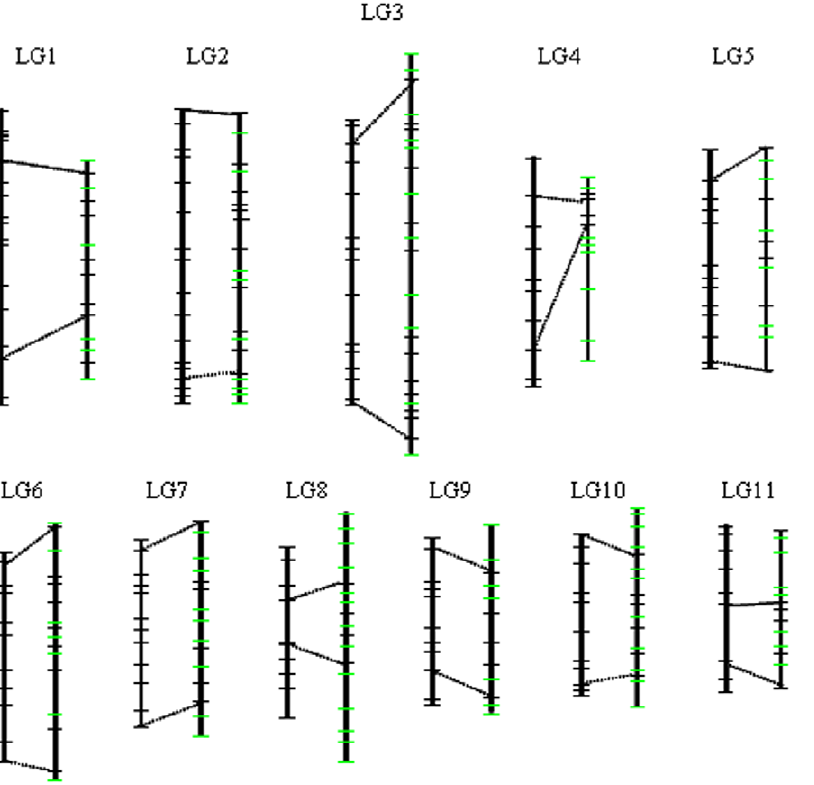
Figure 2. Comparison of the asparagus bean ‘ZZ’ map with the cowpea ssp. unguiculata consensus map. For each LG, on the left is the consensus map and on the right is the ZZ map. The length of each vertical line is proportional to the length (cM) of the corresponding LG. Fragments aligned by dashed lines indicate regions covered by SNP markers shared in the two maps. Black and green horizontal bars indicate SNP and SSR markers, respectively. For clarity of presentation, note that not all mapped loci were included in the figure.